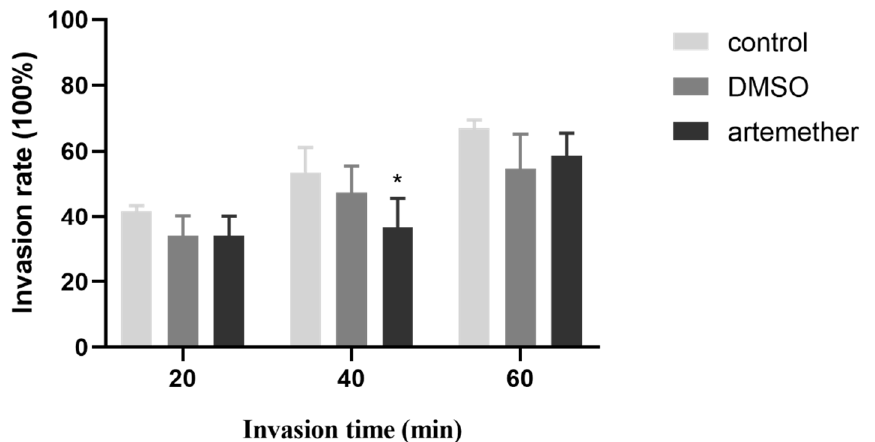
Figure 5. Effect of artemether on the invasion of T. gondii was evaluated by two immunofluorescent dyes. T. gondii invasion rate was evaluated using two immunofluorescent dyes. RH tachyzoites were treated with artemether for 20, 40 and 60 min, respectively. The ratio of the invasion number to the total number of tachyzoites is termed the invasion rate. Three independent experiments were performed and three technical replicates were included in each experiment. * p < 0.05.